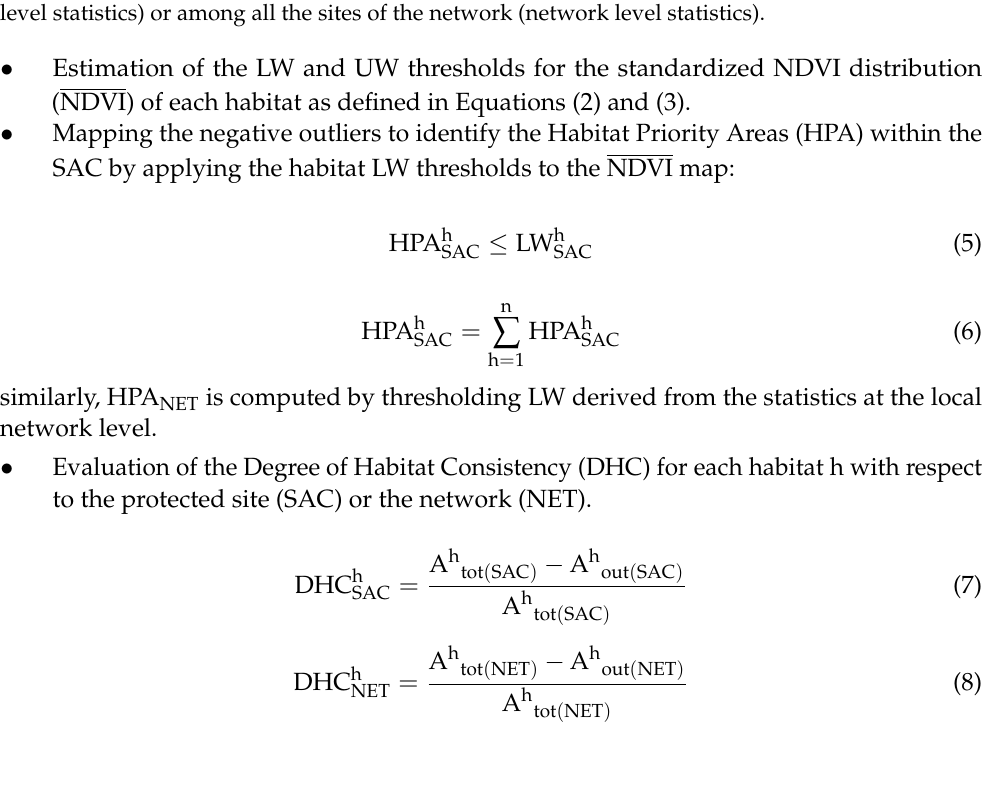
Figure 2. Flowchart of the procedure designed for estimating the Degree of Habitat Consistency (DHC) and identifying the Habitat Priority Areas (HPA) at level of a single protected site (SCI/SAC level statistics) or among all the sites of the network (network level statistics).